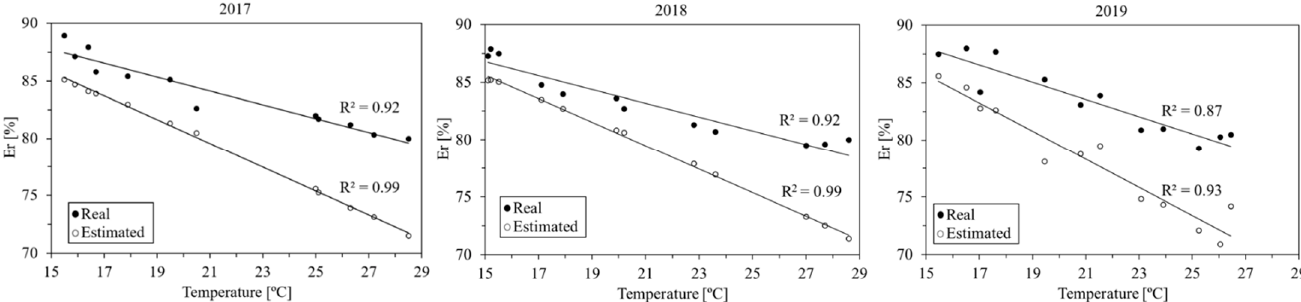
Figure 7. Real values and those estimated with the WAVE software of DUPONT on boron rejection efficiency according to the feed water temperature in 2017, 2018 and 2019.